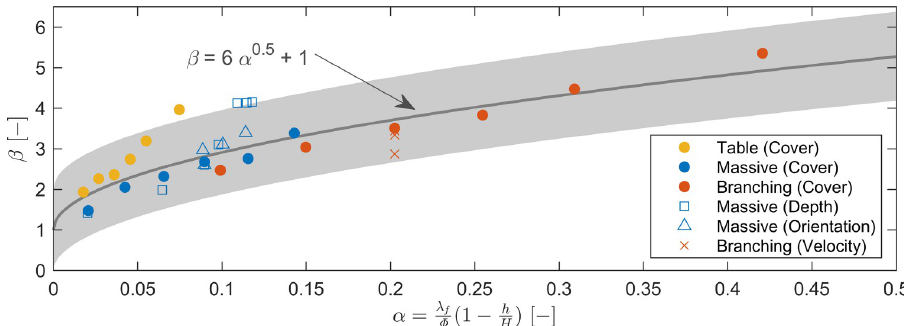
Fig 6. The performance of the predictive model (Eq 8) in collapsing the effects of reef colony morphology, coral cover, water depth, orientation and flow velocity into a single predictor variable for in-reef flow attenuation. The solid markers indicate the coral cover cases for the three archetypal coral forms. The open markers indicate cases where depth, orientation or velocity (as indicated in brackets in the legend) were varied systematically for one coral morphology. The equation for the line of best fit is indicated on the plot, with the shading representing the 95% prediction interval.